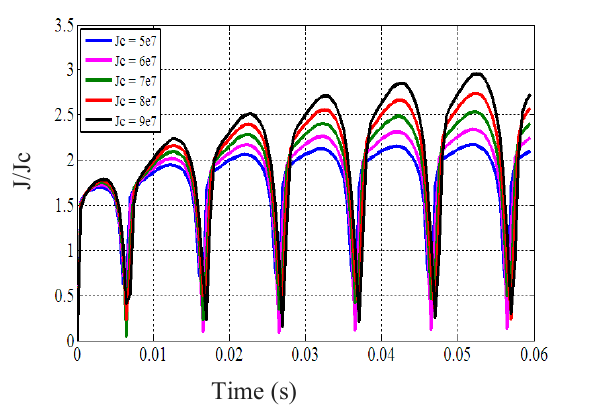
Figure 6: The variation of the ratio J / Jc of the pellet A for different values of Jc as a function of